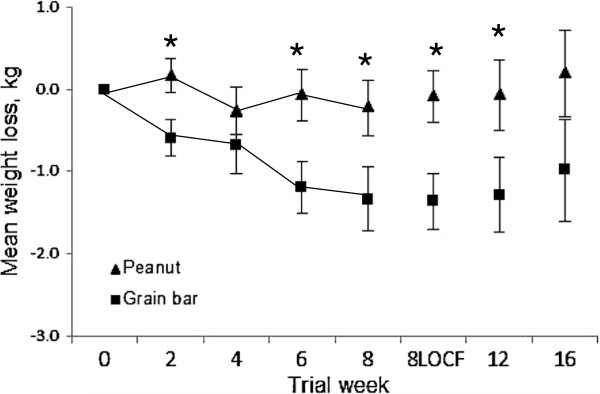
Change from baseline for body weight during the 8-week trial and the subsequent 8-week follow-up period. Data for trial weeks 2–8 represent participants who completed the 8-week trial (n = 23 and 21 for peanut and grain bar group respectively). Follow-up data represent 23/19 and 21/18 participants for peanut/grain bar groups at weeks 12 and 16 respectively. 8LOCF data represents the intention-to-treat LOCF method at week 8 (n = 26 and 24 for peanut and grain bar groups). Asterisks indicate significant difference between groups (p < 0.05).